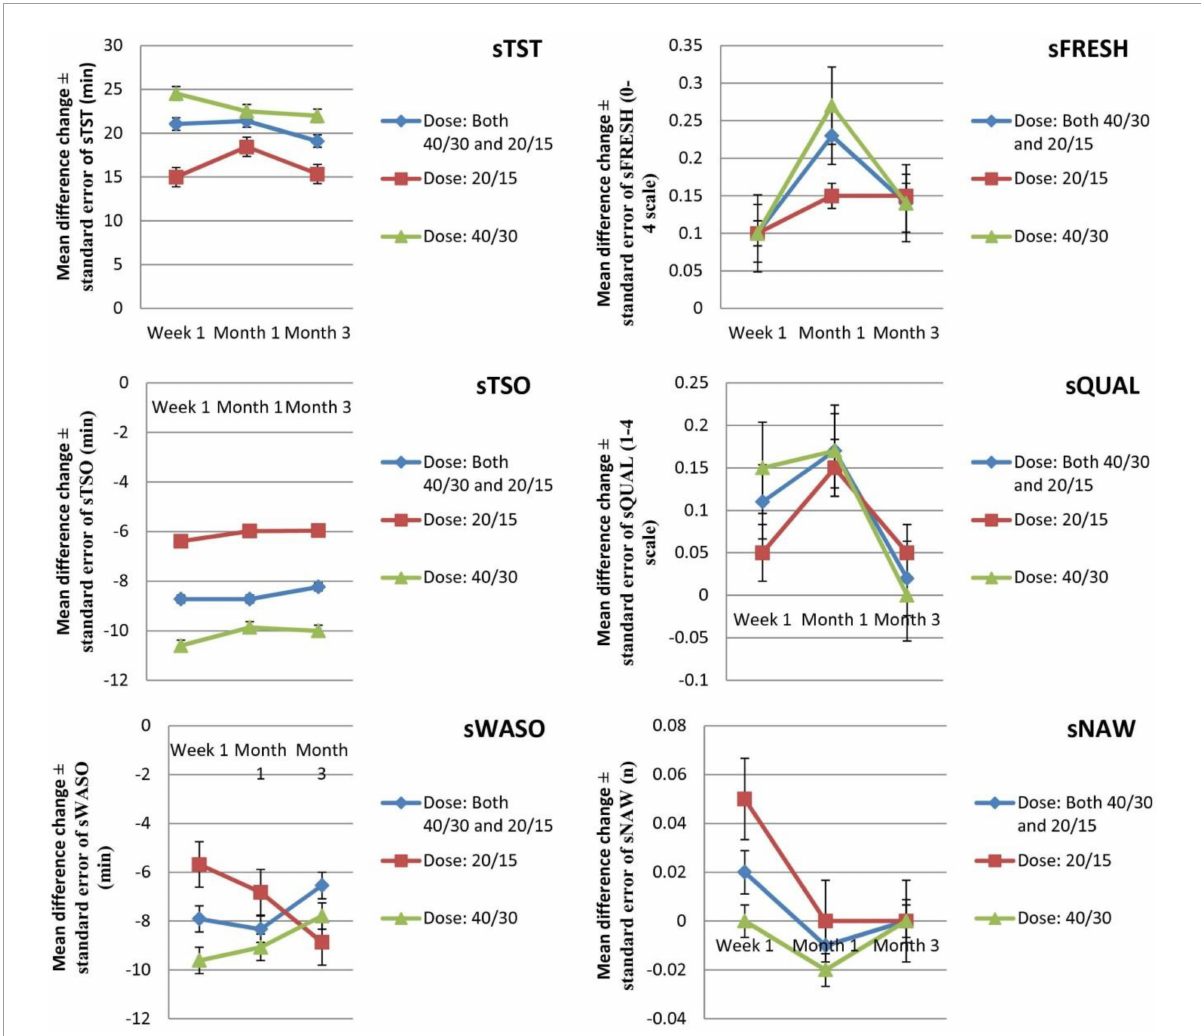
FIGURE2 The mean changes efficacy outcome (diary measures) results from baseline in suvorexant vs. placebo for three times. sFRESH, subjective refreshed feeling on waking (0–4 scale); sNAW, subjective number of awakenings; sQUAL, subjective quality of sleep (1–4 scale); sTSO, subjective time to sleep onset (minutes); sTST, subjective total sleep time (minutes); sWASO, subjective wake after sleep onset (minutes); WMD, weighted mean